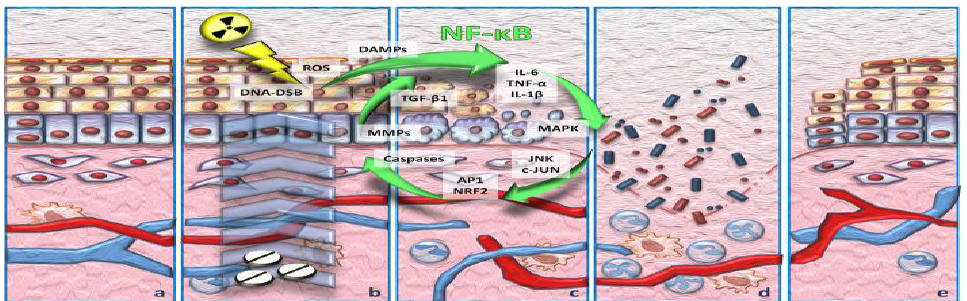
Figure 1. (after Claudio Pulito-2020) [17]. Pathobiology of oral mucositis: ( a ) normal tissue; ( b ) first phase and initial injury response, ( c ) injury signal boost, ( d ) ulceration, ( e ) tissue re-epithelialization. Initially, OM is clinically manifested by a mucosal rash, with no other lesions or ul-